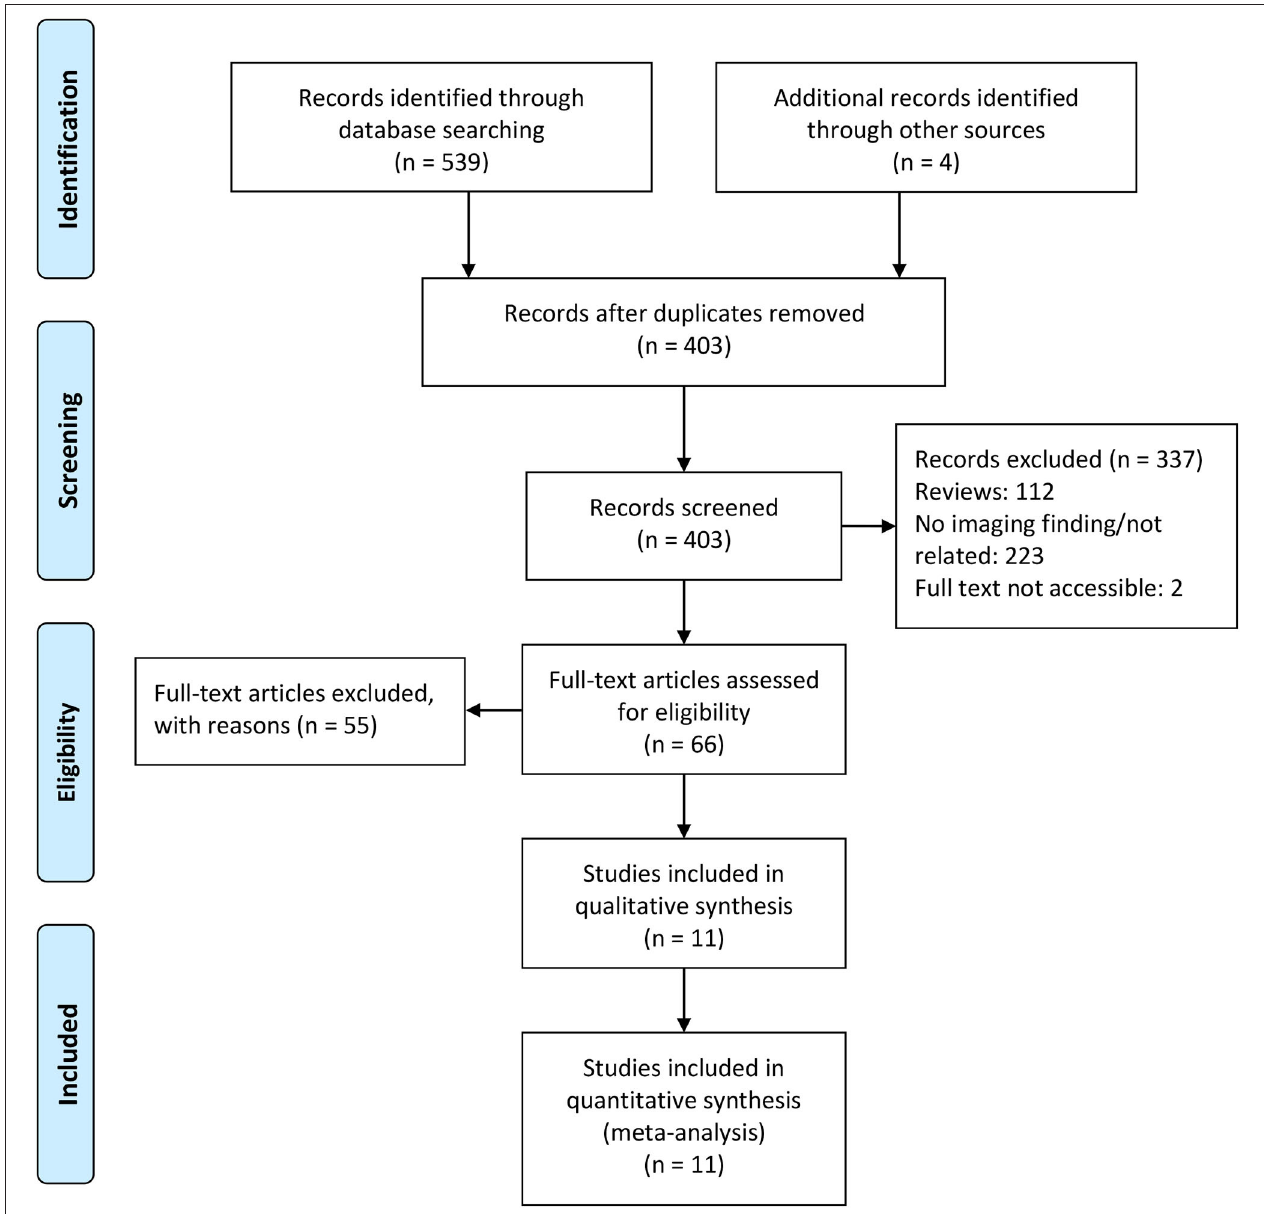
FIGURE 1 | PRISMA flow diagram of literature